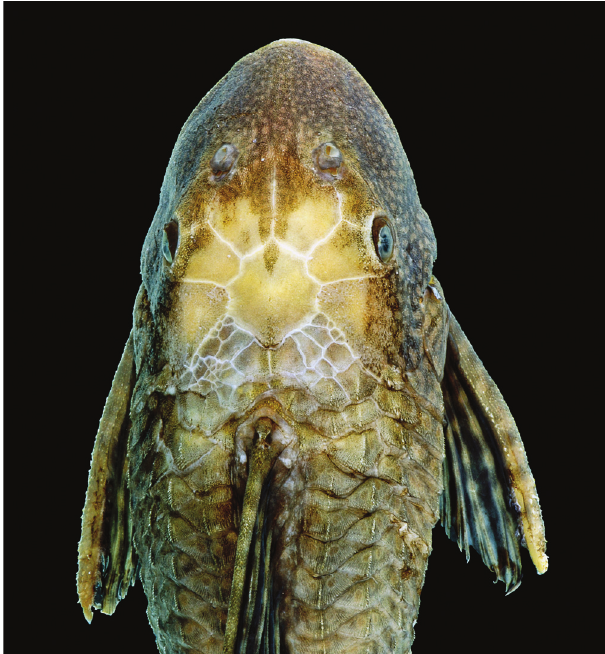
Fig. 3. Hypostomus delimai , INPA 2473, 167.1 mm SL, highlighting complex of platelets limiting supraoccipital and anterior portion of predorsal region. The skin of predorsal region was removed to evidence plate limits.